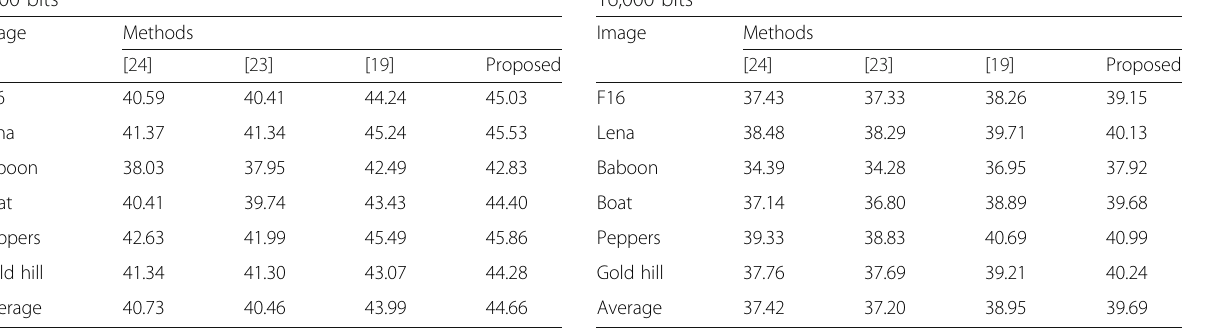
Table 2 Comparison in terms of PSNR (dB) with payload size of Table 1 Comparison in terms of PSNR (dB) with payload size of